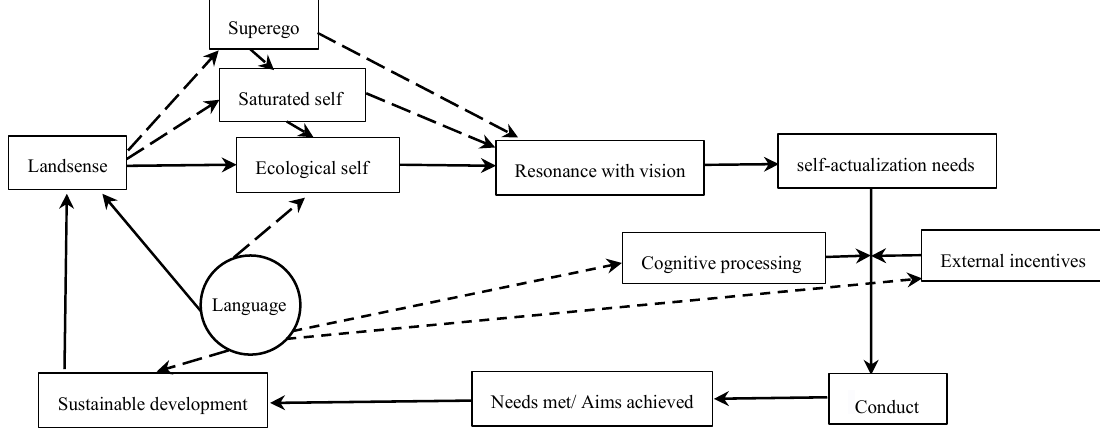
Figure 1. The psychological perception process of landsense creation.